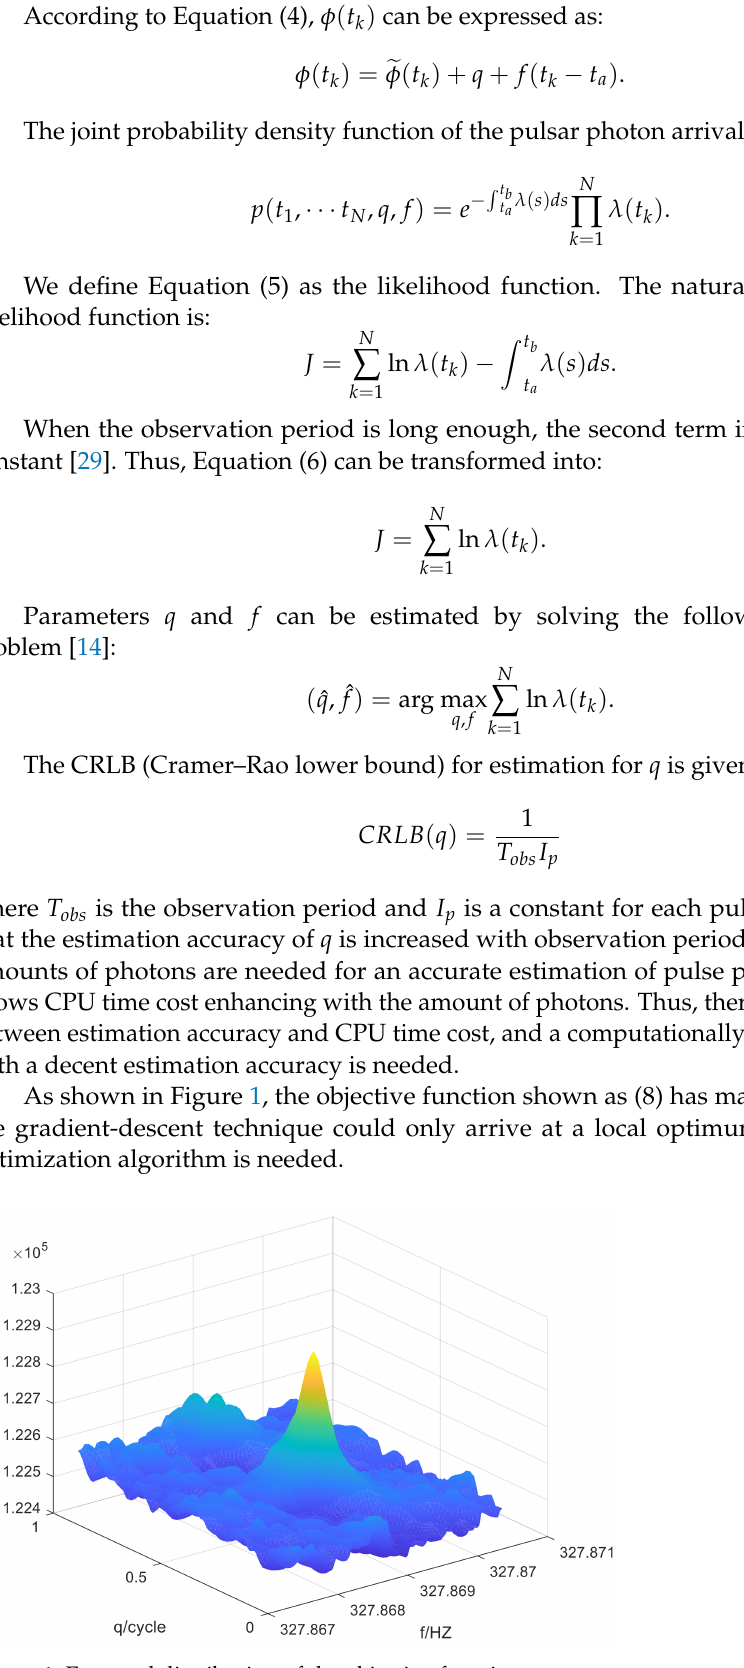
Figure 1. Extremal distribution of the objective